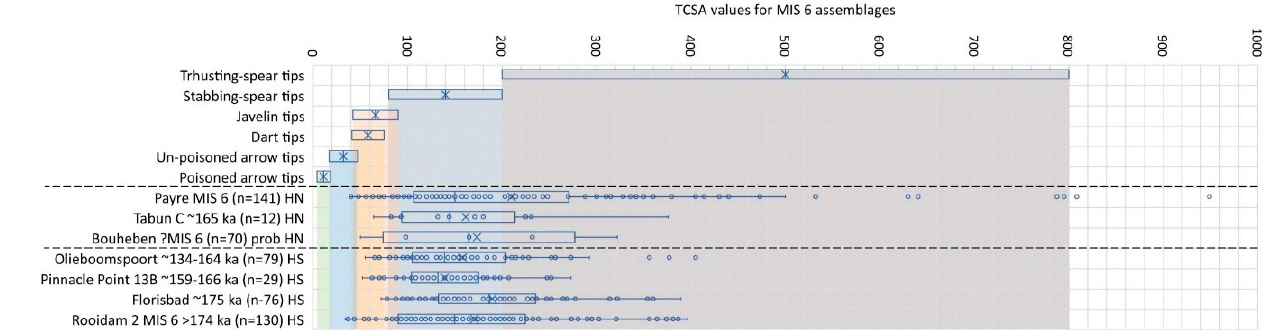
Figure 3. Comparative analysis of TCSA values for assemblages dating to MIS 6. Key: Same as for Figure 2, but HS = assemblages made by Homo sapiens , because these are the only known humans on the African landscape at the time. The key to boxplot information is the same as for Figure 2.